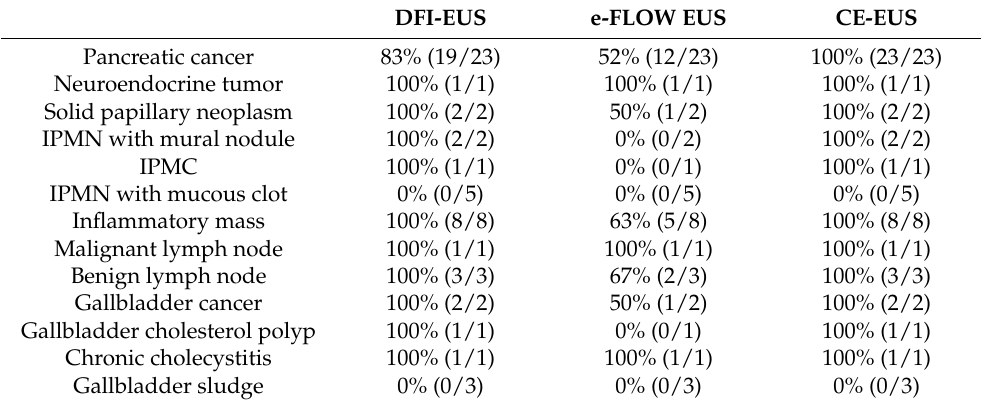
Table 2. Vascular assessment of pancreatobiliary lesions by DFI-EUS, e-FLOW EUS, and